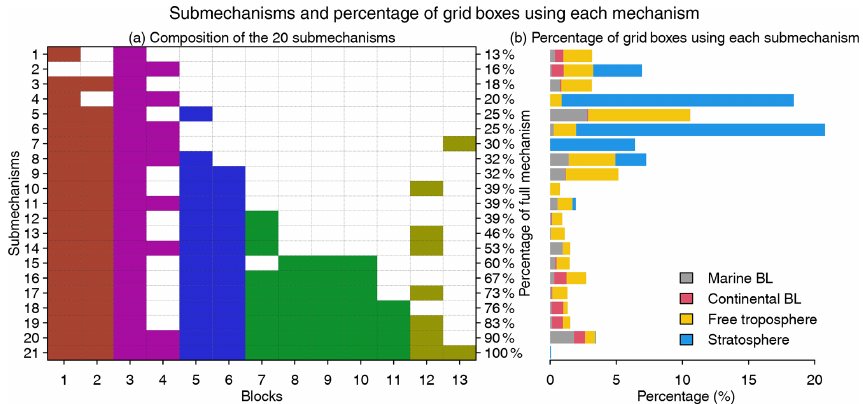
Figure 5. Submechanisms and the percentage of grid boxes using each mechanism. Panel (a) shows the composition of the 20 submechanisms and the full mechanism (the 21st one) as well as the percentage of species from the full mechanism that are treated as fast in each of them. Colors denote species block types as defined in Fig. 4. Panel (b) shows the percentage of grid boxes using each submechanism in the marine boundary layer (BL, 0–2km altitude), continental BL, free troposphere (2km to tropopause), and